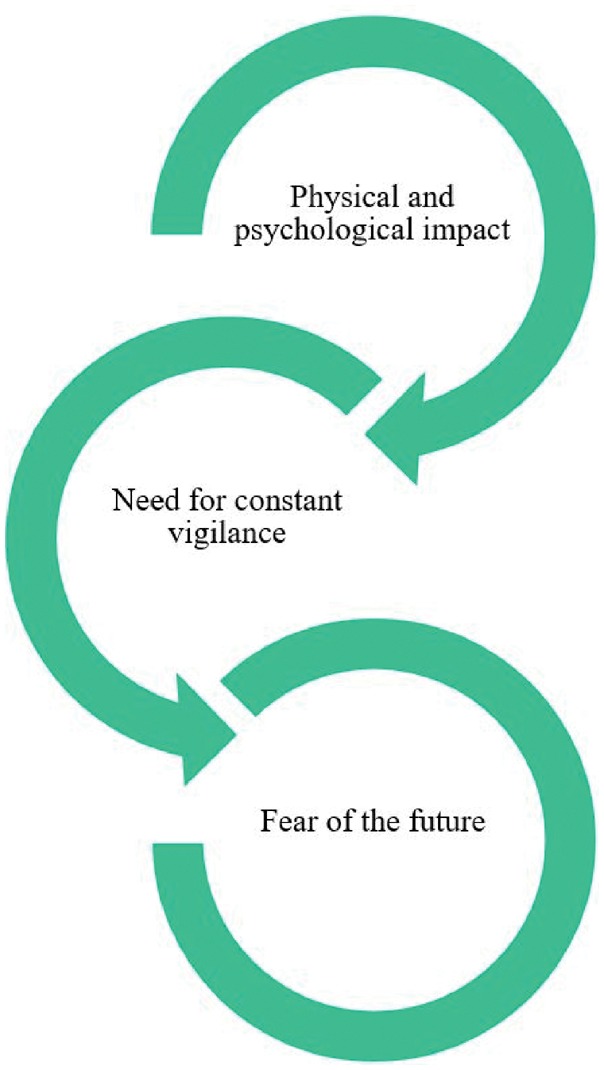
Emergent themes